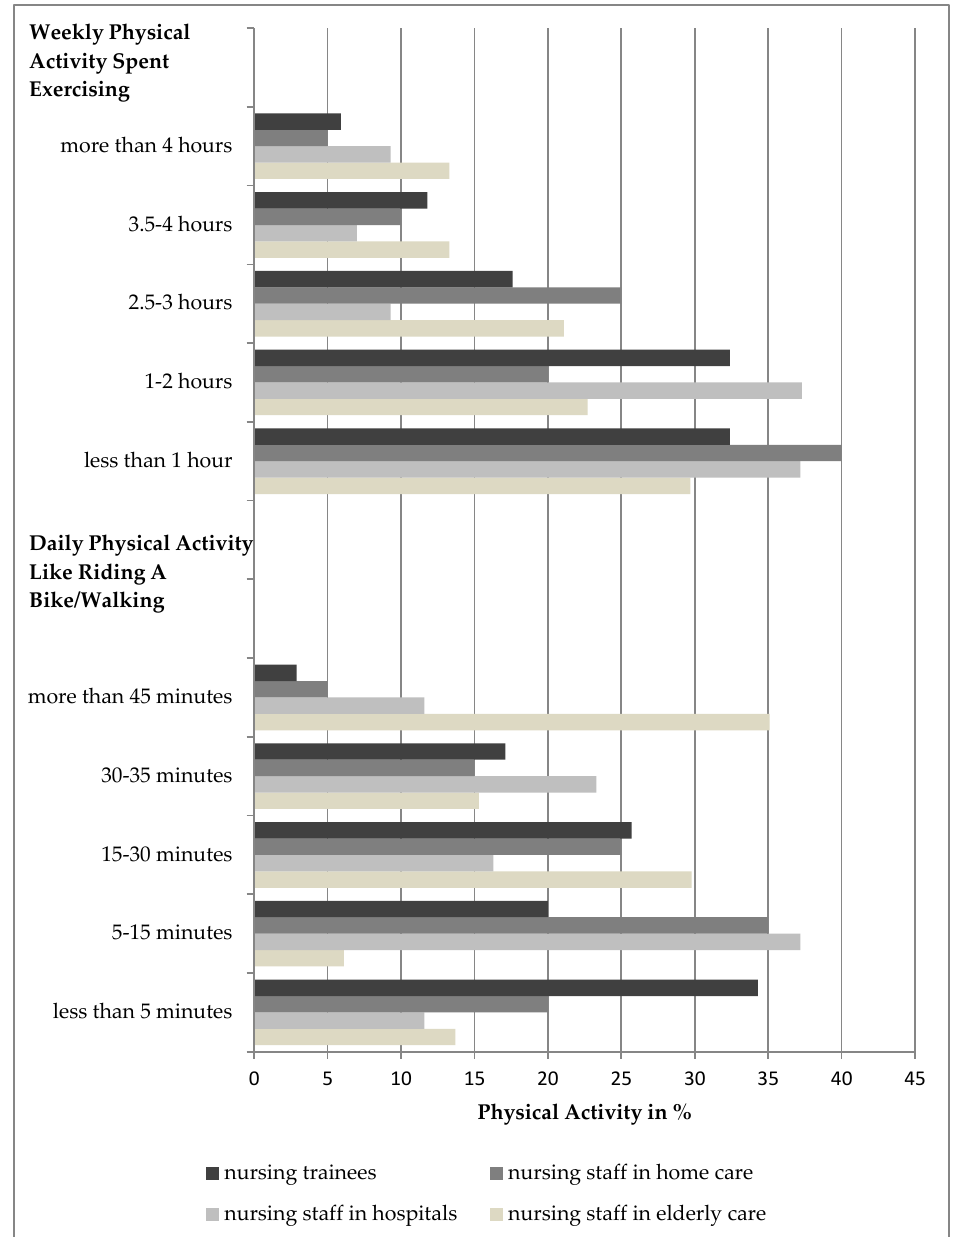
Figure 1. Daily and weekly physical activities.